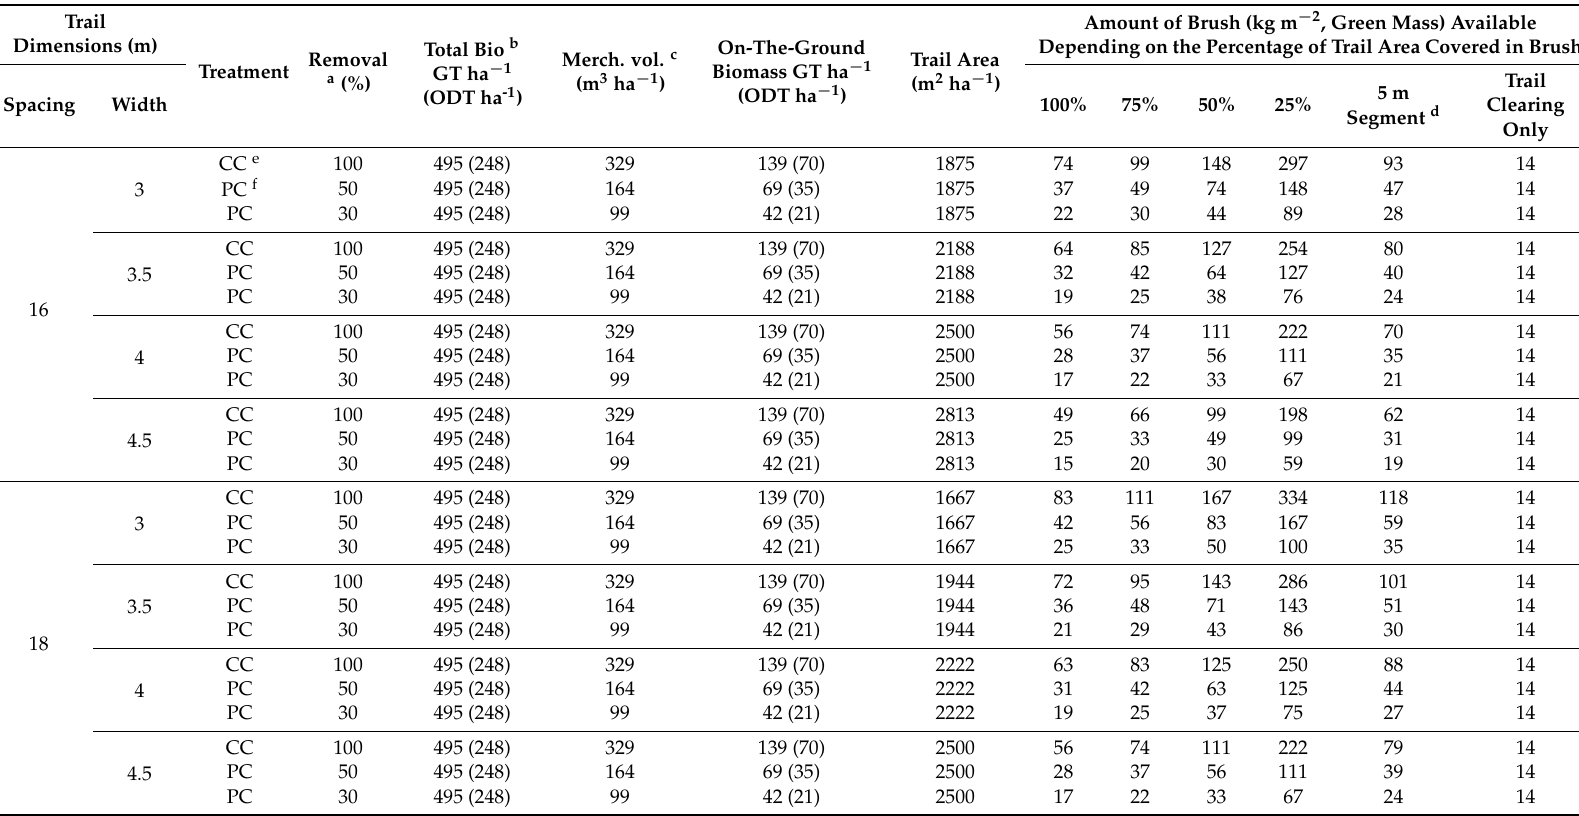
Table A2. Amount of brush available for soil protection as brush mats depending on trail spacing, trail width and varying trail coverage obtained from an artificially regenerated high-yield black spruce stand